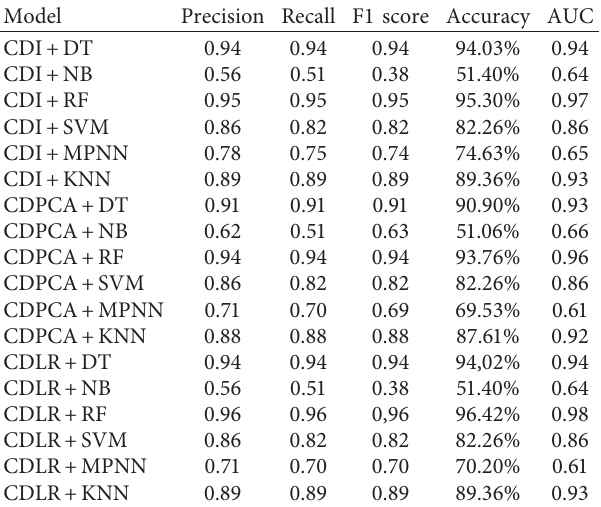
Table 7: Binary classification results without cross validation. Model